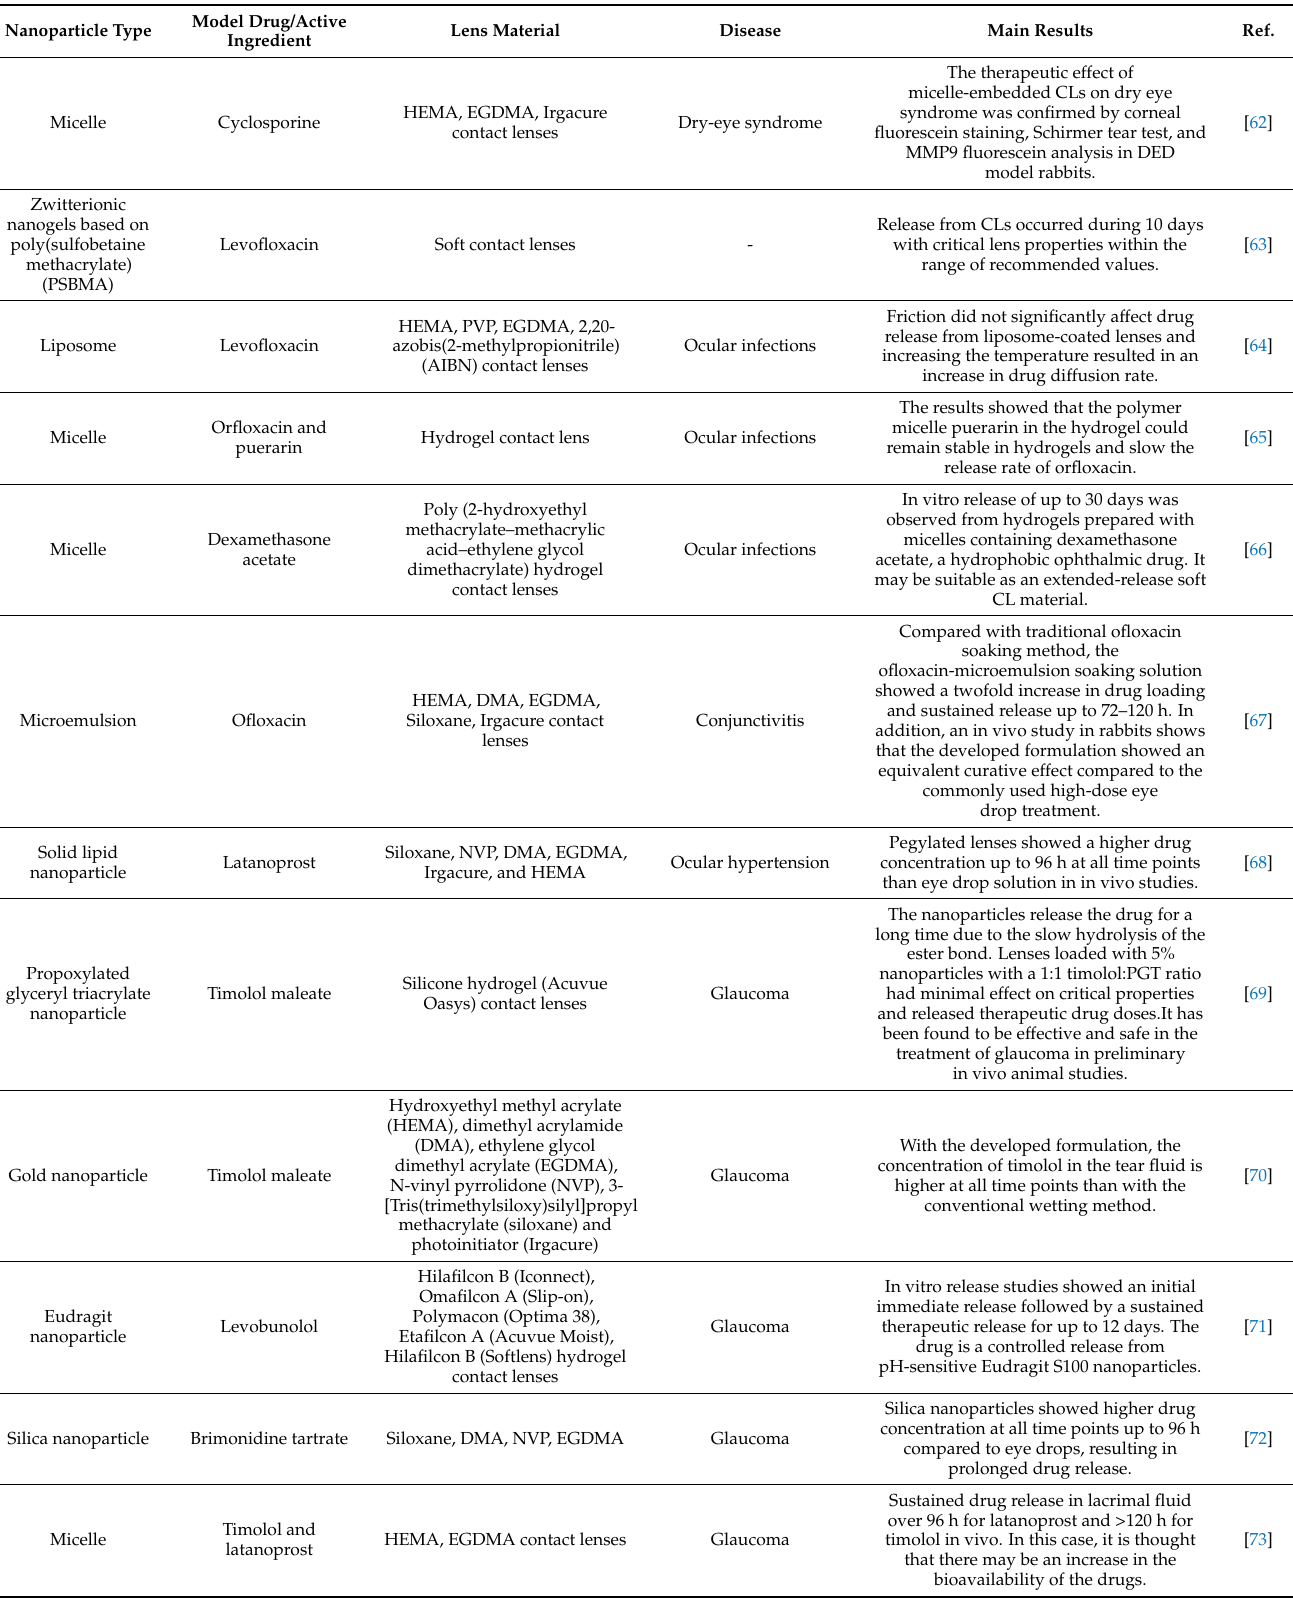
Table 1. Ocular studies with drug/nanoparticle incorporated in contact